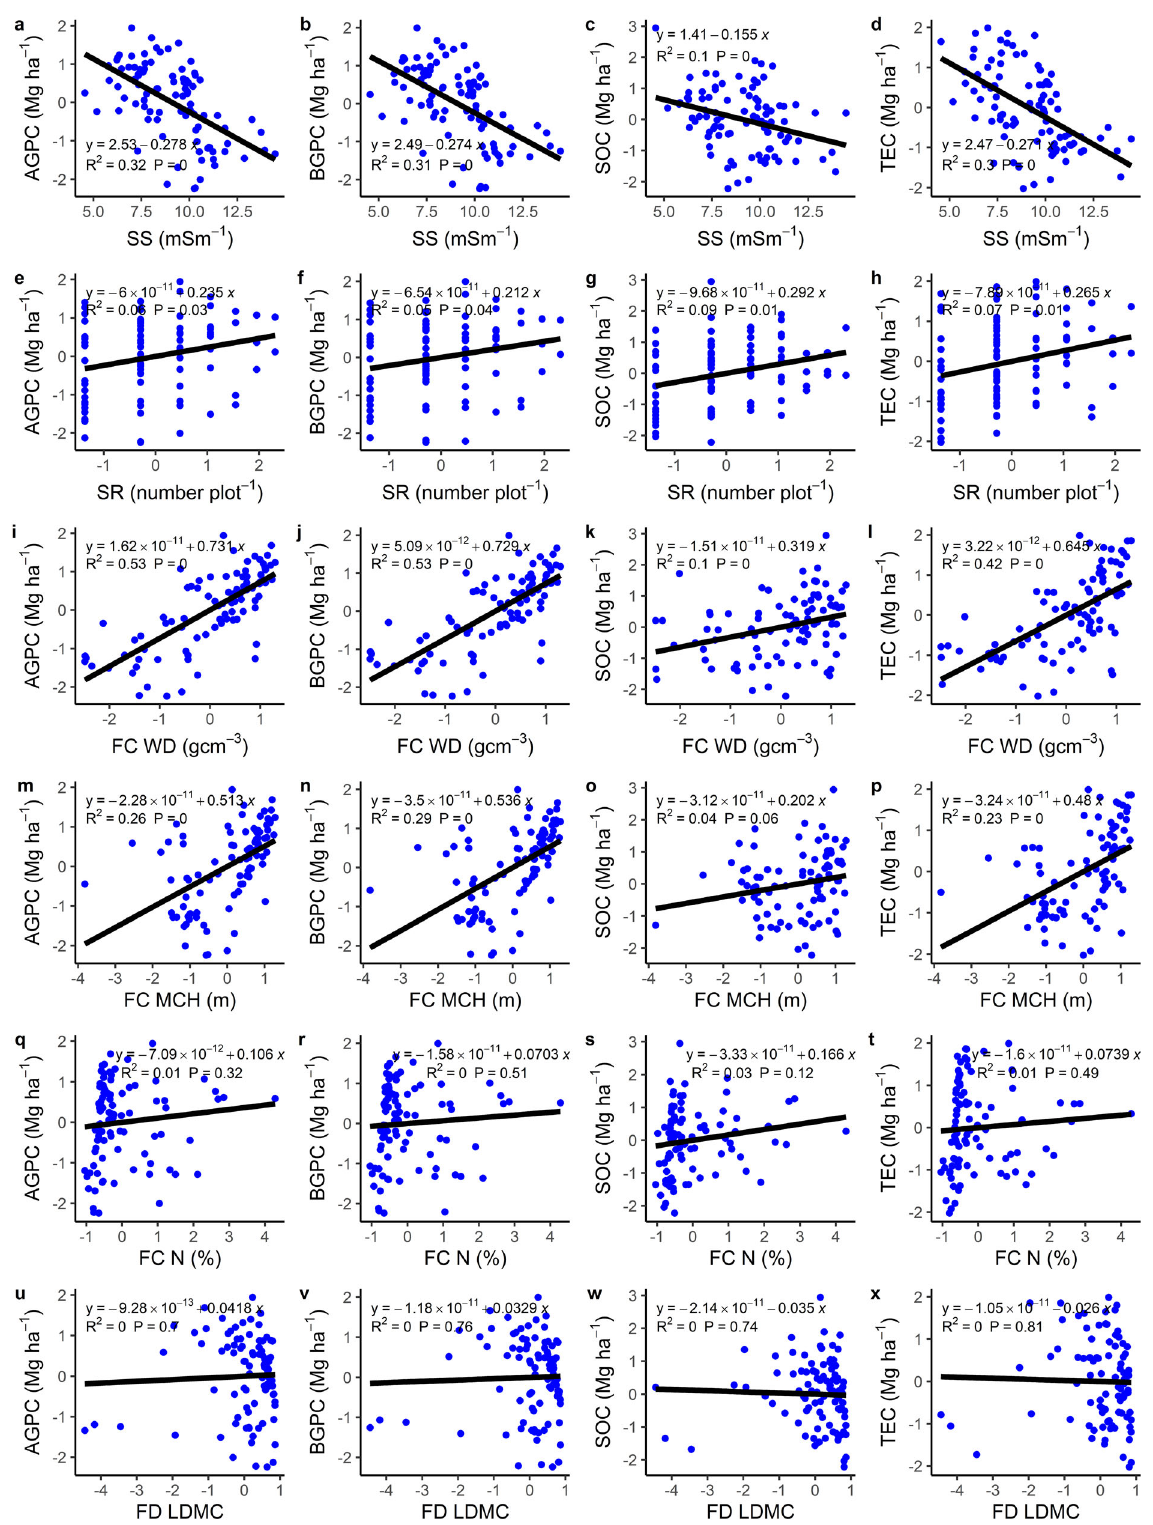
Fig. 1 Bivariate relationships between sediment salinity (SS), species richness (SR), functional composition and diversity of different traits for hypothesized causal paths in the structural equation models. a – x Sediment salinity ( a – d ), species richness (SR; e – h ), functional composition wood density (FC WD; j – l ), functional composition maximum canopy height (FC MCH; m – p ), functional composition leaf litter nitrogen (FC N; q – t ), functional diversity leaf litter dry matter content (FD; u – x ) versus aboveground plant biomass carbon (AGPC), belowground plant biomass carbon (BGPC), sediment organic carbon (SOC) and total ecosystem carbon (TEC), respectively. Each blue point represents a sampling plot, while the black line indicates the fi tted regression line. P value indicates the signi fi cance